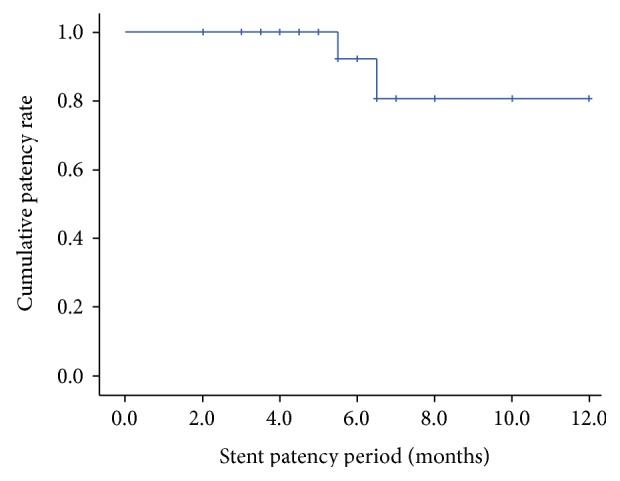
Kaplan-Meier analysis of mean stent patency duration in patients undergoing EUS-BD.